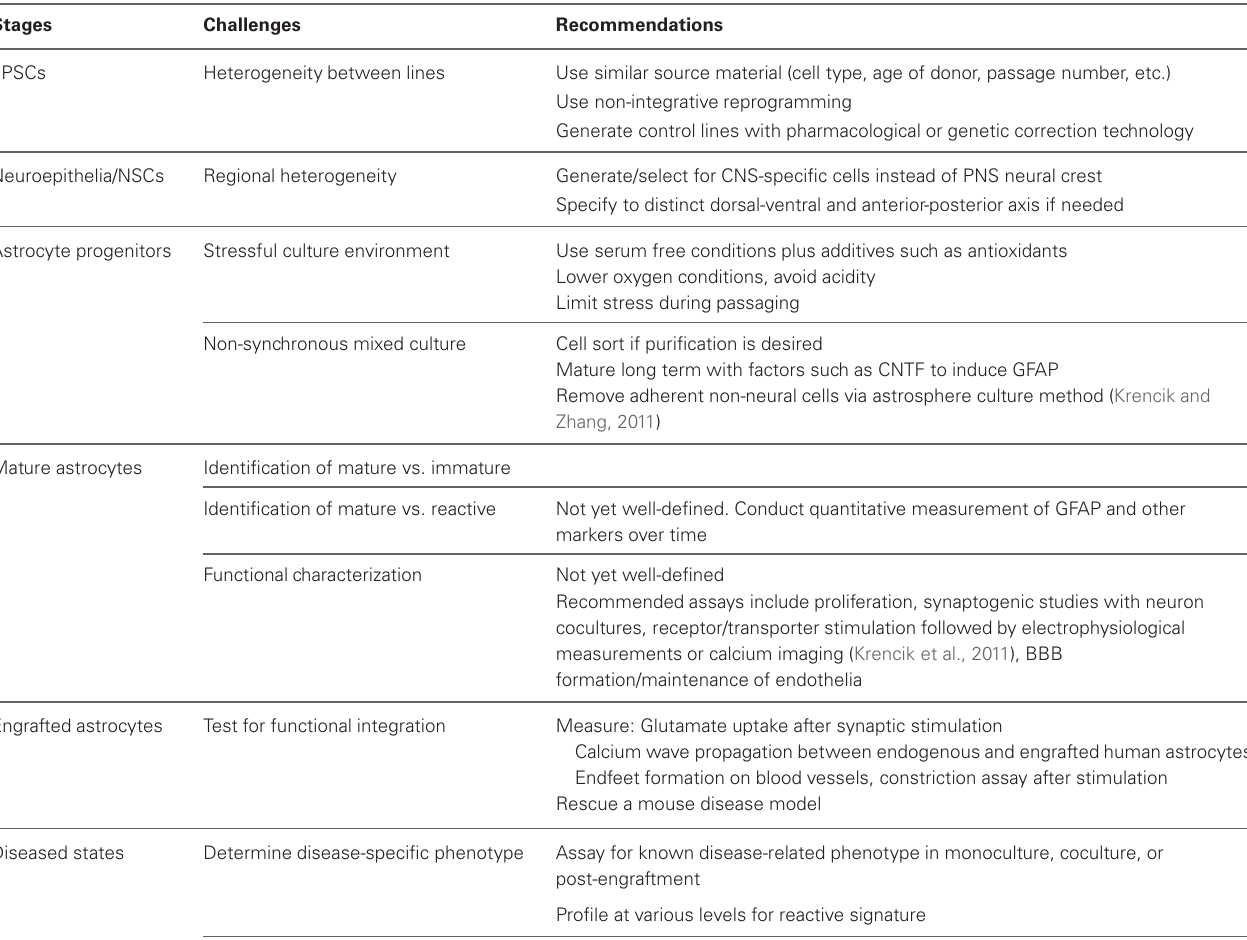
Table 1 | Atlas for using hPSC-astrocytes in normal and disease